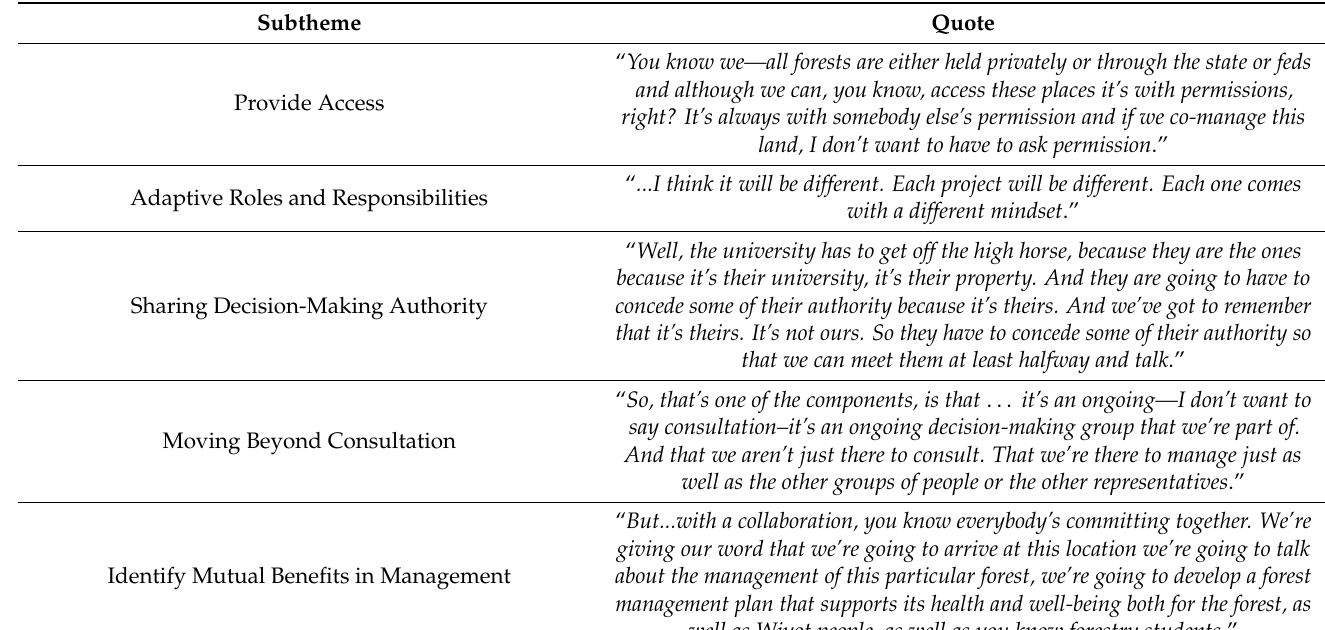
Table 2. Examples of the assignment into subthemes of quotes relating to the theme of co-management are taken from participant